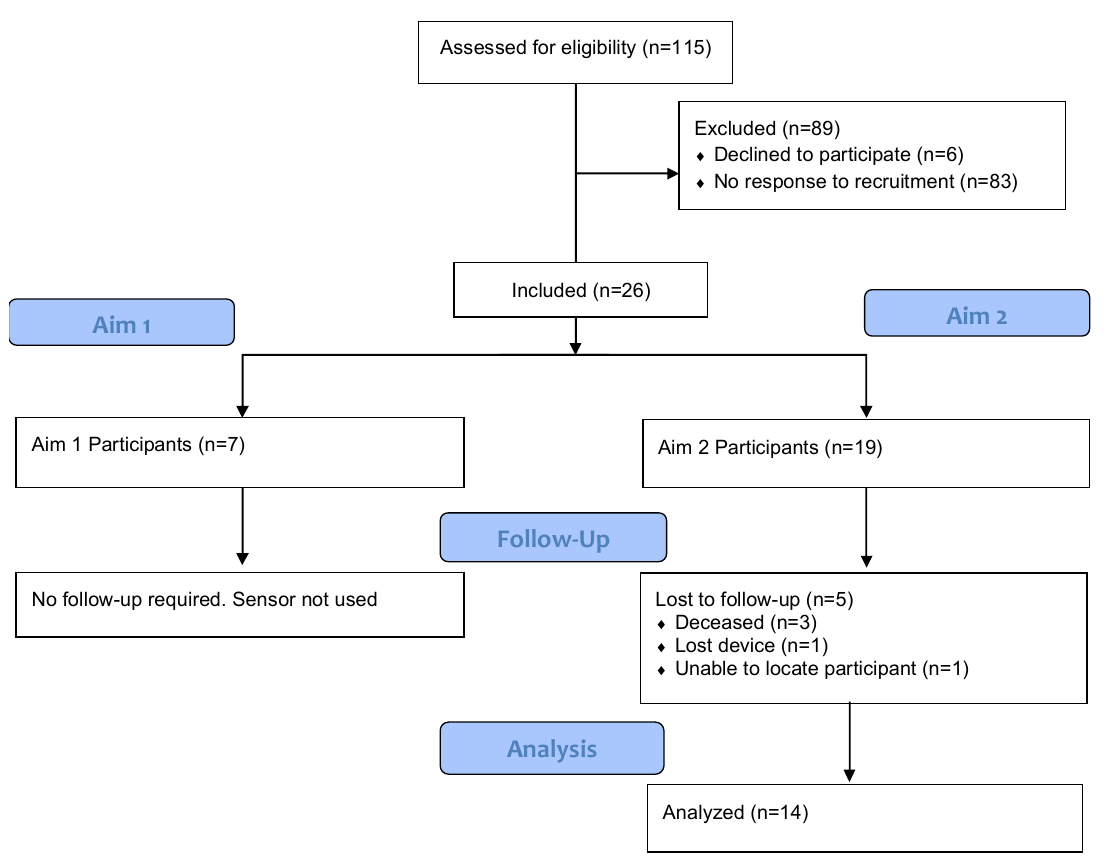
Figure 1. Intervention Design: Consort chart for the study.